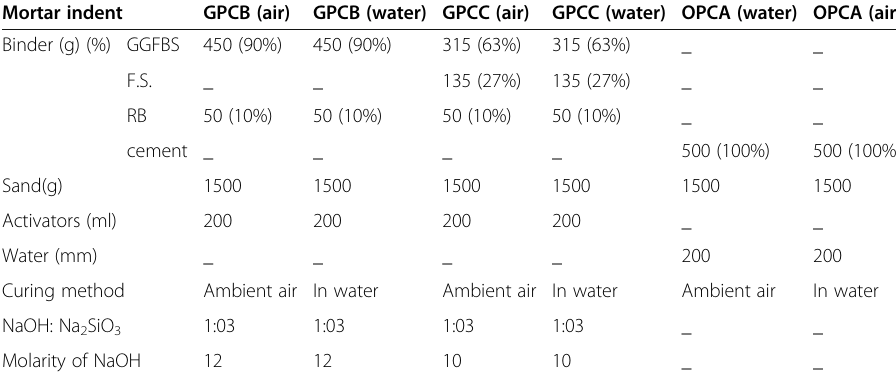
Table 4 Mix id and mix batch composition of mortar mixes Mortar indent